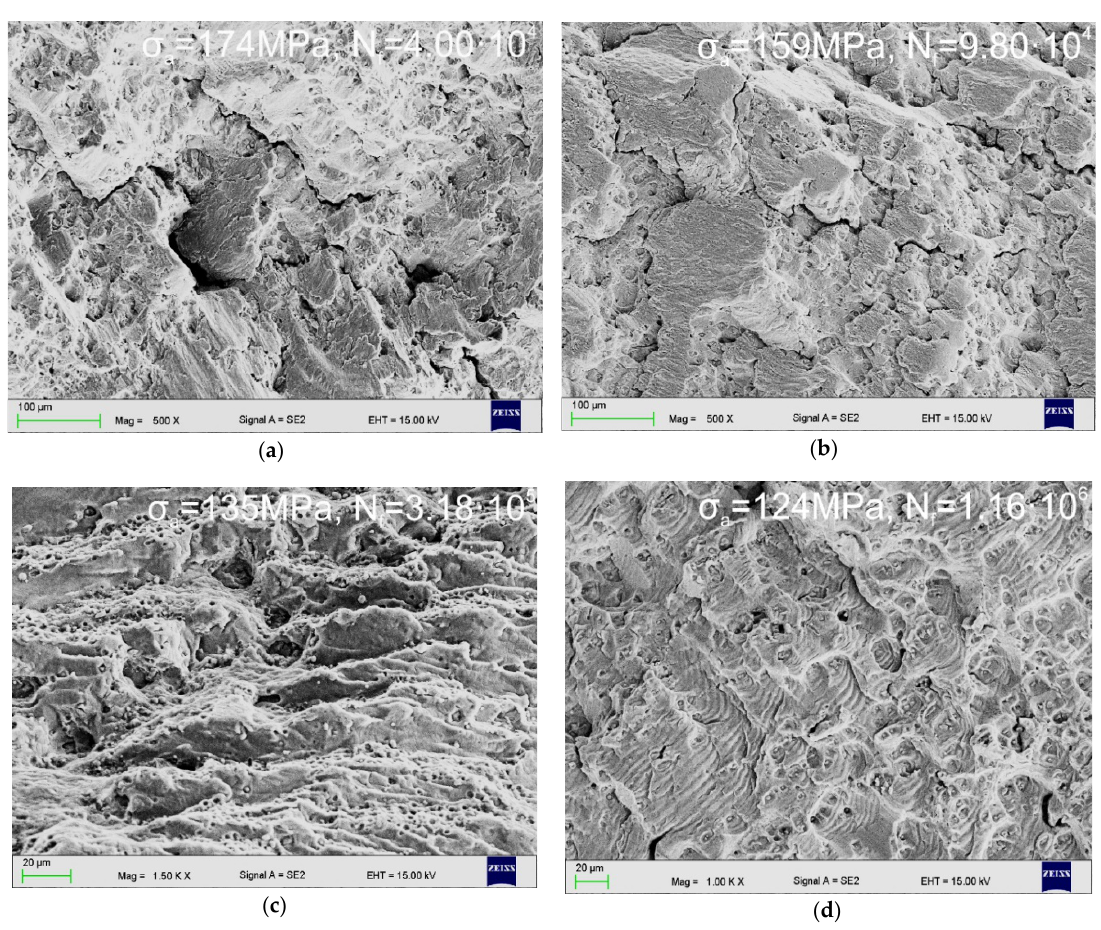
Figure 9. ( a ) Secondary cracks and islands of cleavage planes on the surface of the examined alloy ; ( b ) Secondary cracks along the jogs of cleavage planes; ( c ) Traces of plastic deformation on the surfaces of jogs ; ( d ) Systems of fatigue striae on the surface of the specimens.